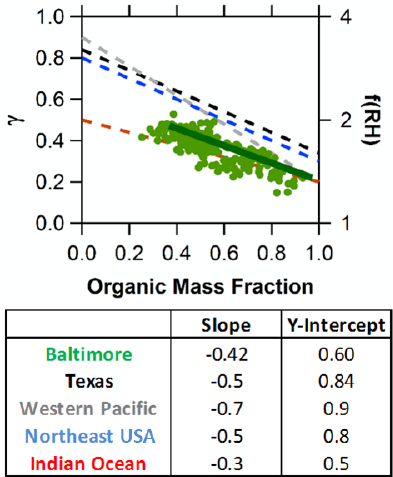
Figure 8. Relationship between γ (at 532nm) and organic mass fraction for the present study (data below 1km), Texas (Massoli et al., 2009), the western Pacific, the northeast USA, and the Indian Ocean (Quinn et al., 2005). The organic mass fraction is found by dividing the WSOM by the total mass measured by the PILS and SP2. Other studies used organic mass measured by aerosol mass spectrometer or thermo-optical methods. The ratio of scattering at 80%RH to 20%[ f (RH)] is shown on the right y axis (note the irregular